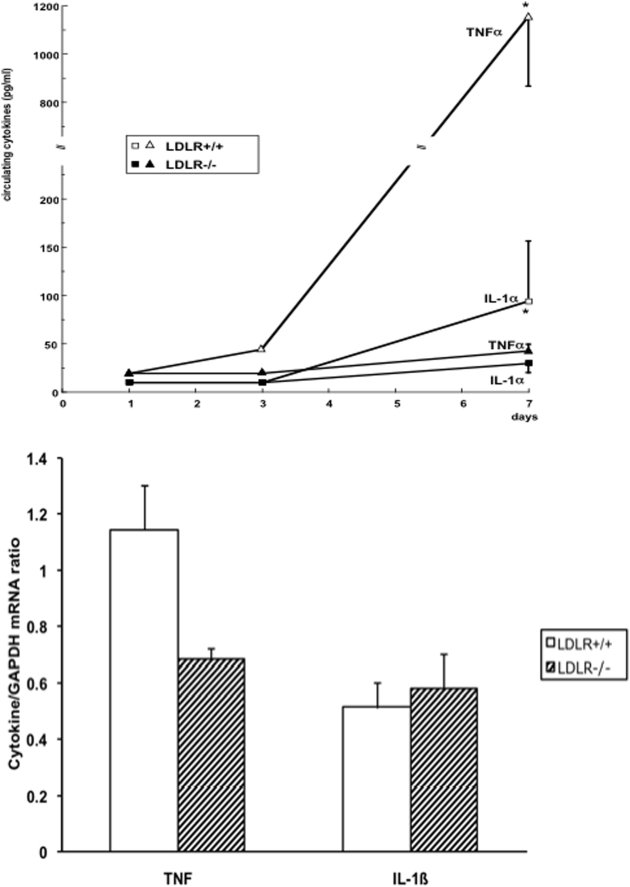
In-vivo cytokine production in LDLR+/+ and LDLR−/− mice infected with S. typhimurium.LDLR−/− and control (LDLR+/+) C57Bl/6J mice were infected i.v. with 102 cfu of S. typhimurium. After 1, 3 or 7 days, groups of 5 mice/group were sacrificed, and circulating concentrations of cytokines in the plasma were measured by specific ELISA. In a separate experiment, TNF and IL-1β mRNA in the spleens of LDLR+/+ and LDLR−/− mice was assessed by semi-quantitative RT-PCR, and expressed as ratio to GAPDH mRNA expression. Data are presented as means±SD, *p<0.05.